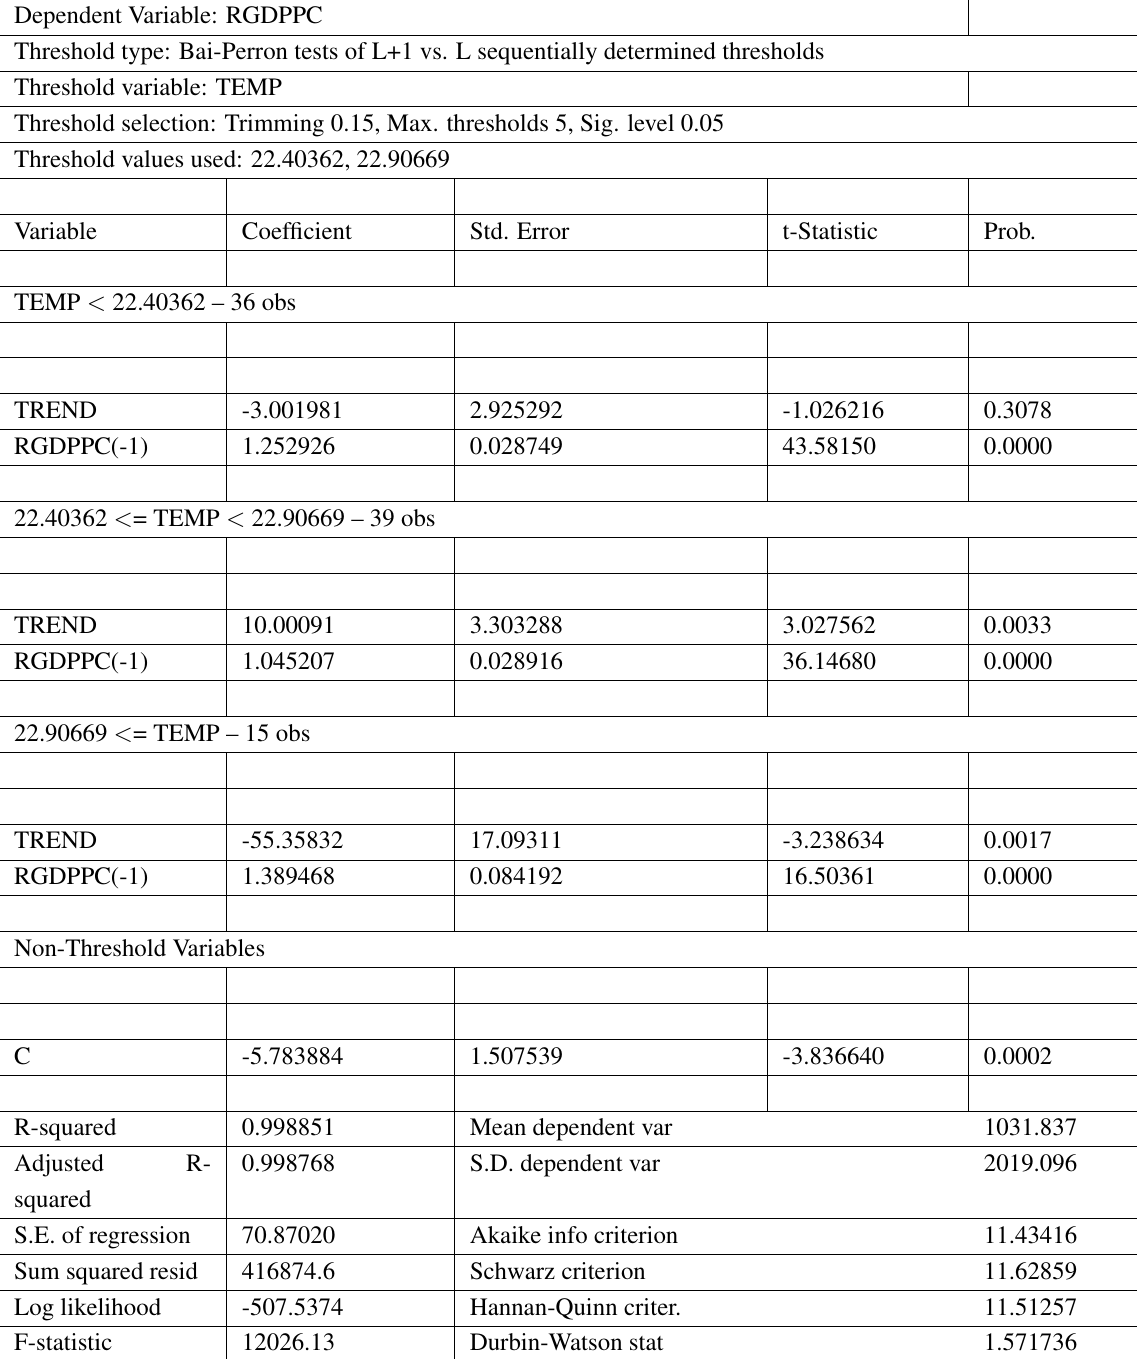
Table 2. Environmental-Economic Growth GDP per capita Threshold